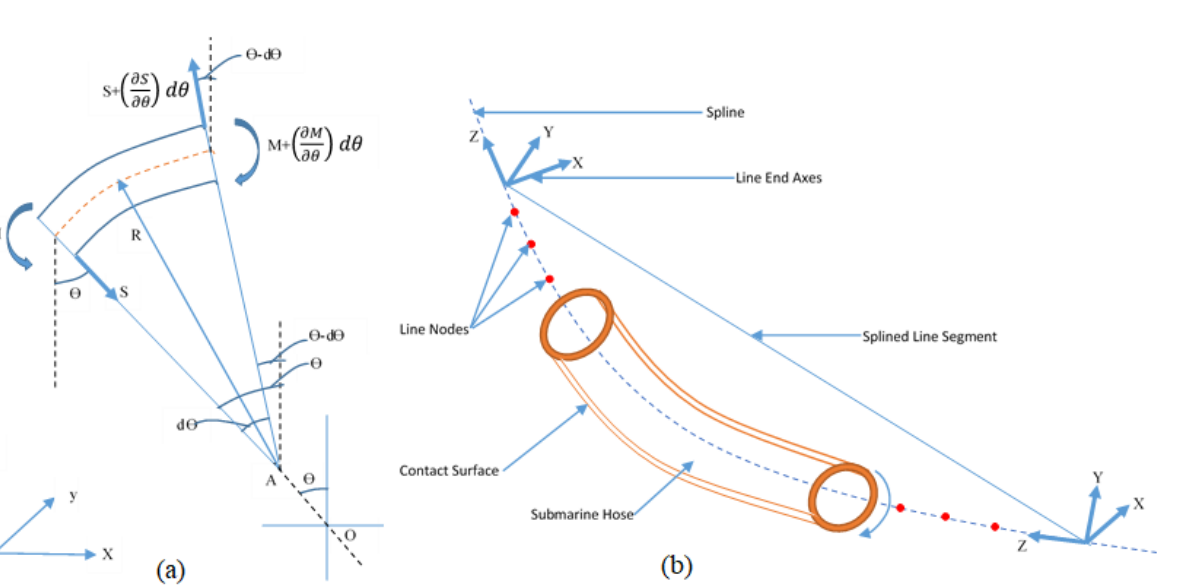
Figure 3. An illustration showing ( a ) displaced hose-beam element showing moments and forces, and ( b ) Submarine hose segment showing spline line and nodes.